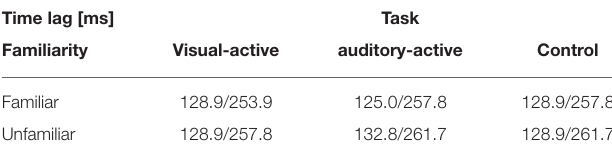
0.0136, p = 0.9744. There was also no significant interaction TABLE 4 | Summary of time lags at the peaks